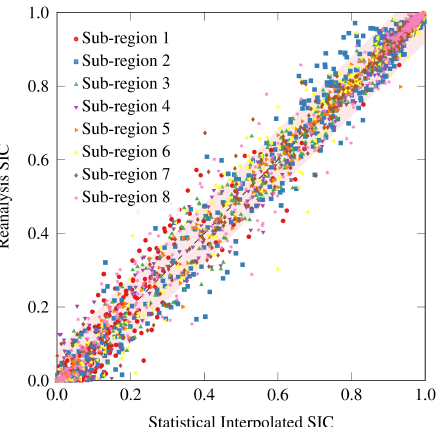
Figure 6. The correlation between interpolated and reanalysis SICs along the NSR.